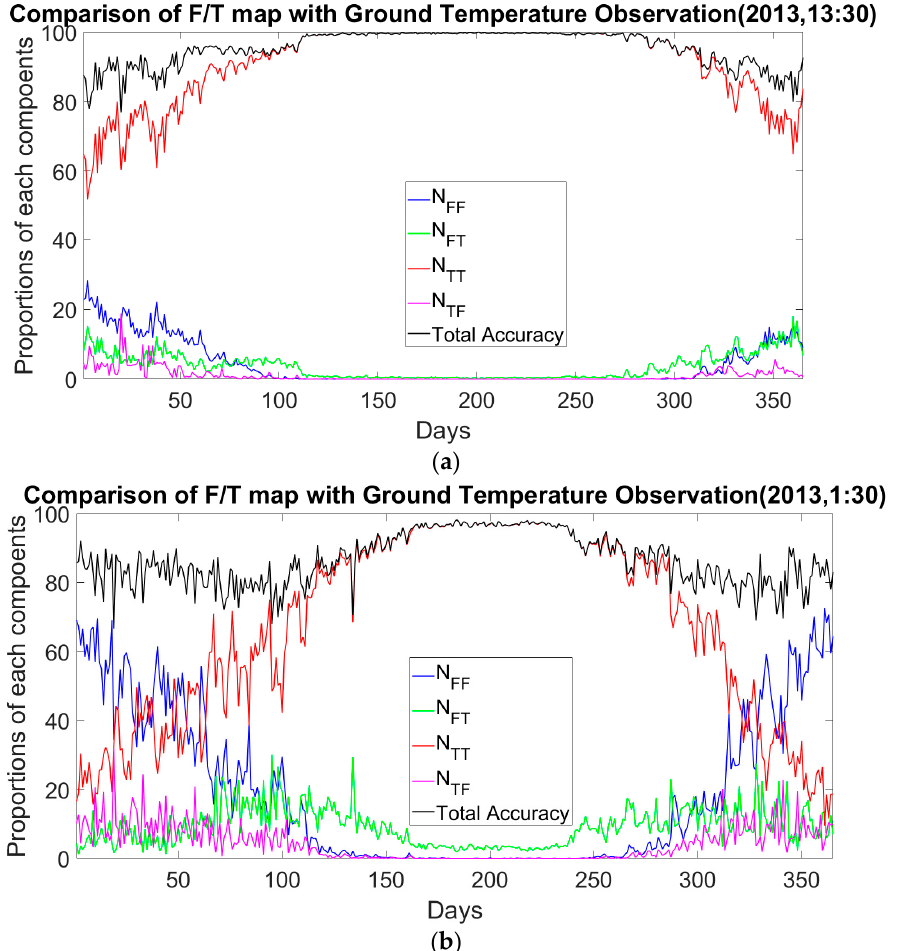
Figure 5. Temporal agreement between in situ measurement and F/T maps for observations at 13:30 ( a ) and 1:30 ( b ).